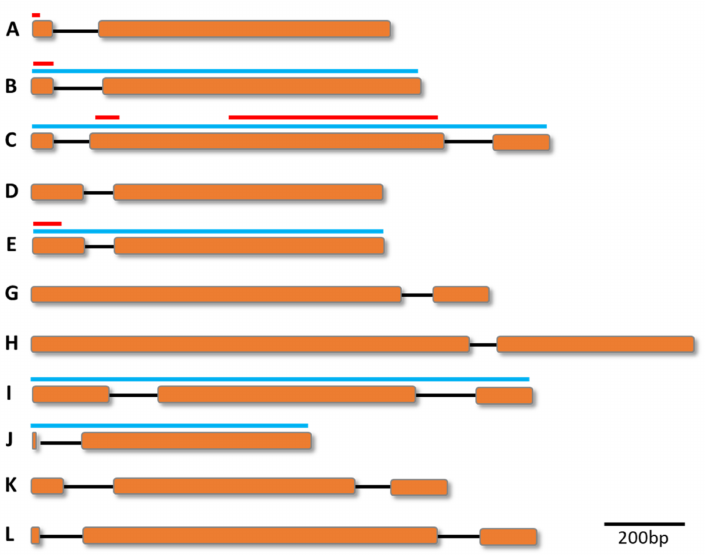
Figure 1. Schematic representation of gene models from the different subfamilies, A–L, of the Plasmodium vivax subtelomeric vir multigene superfamily. Exons are presented as orange boxes and introns as lines. Red bars above subfamilies A, B, C, and E showed the relative position of recombinant proteins or peptides used for an immune response assay. Blue bars above subfamilies